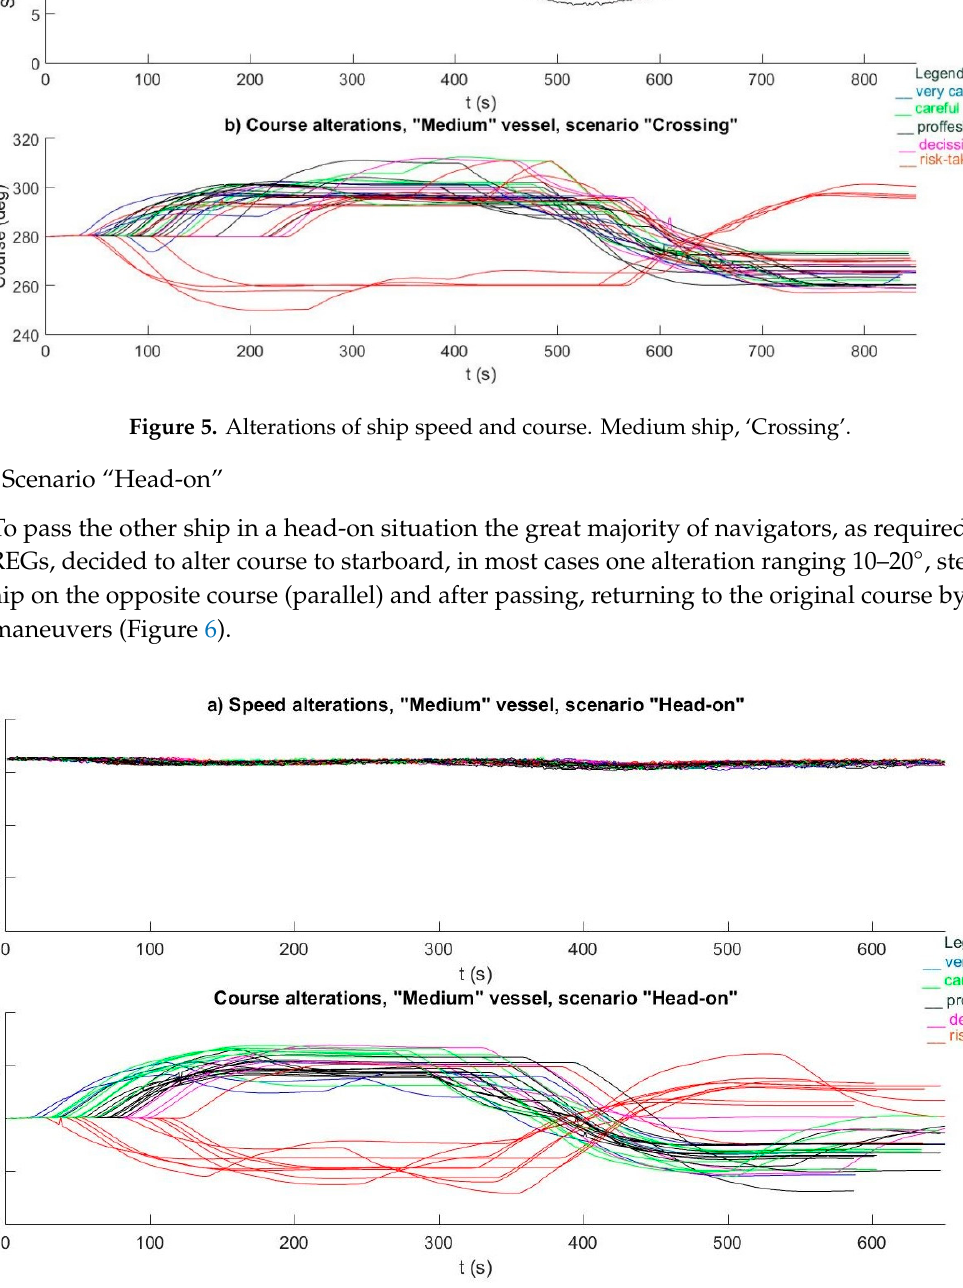
Figure 6. Alterations of speed and course. Medium ship, ‘Head-on’.